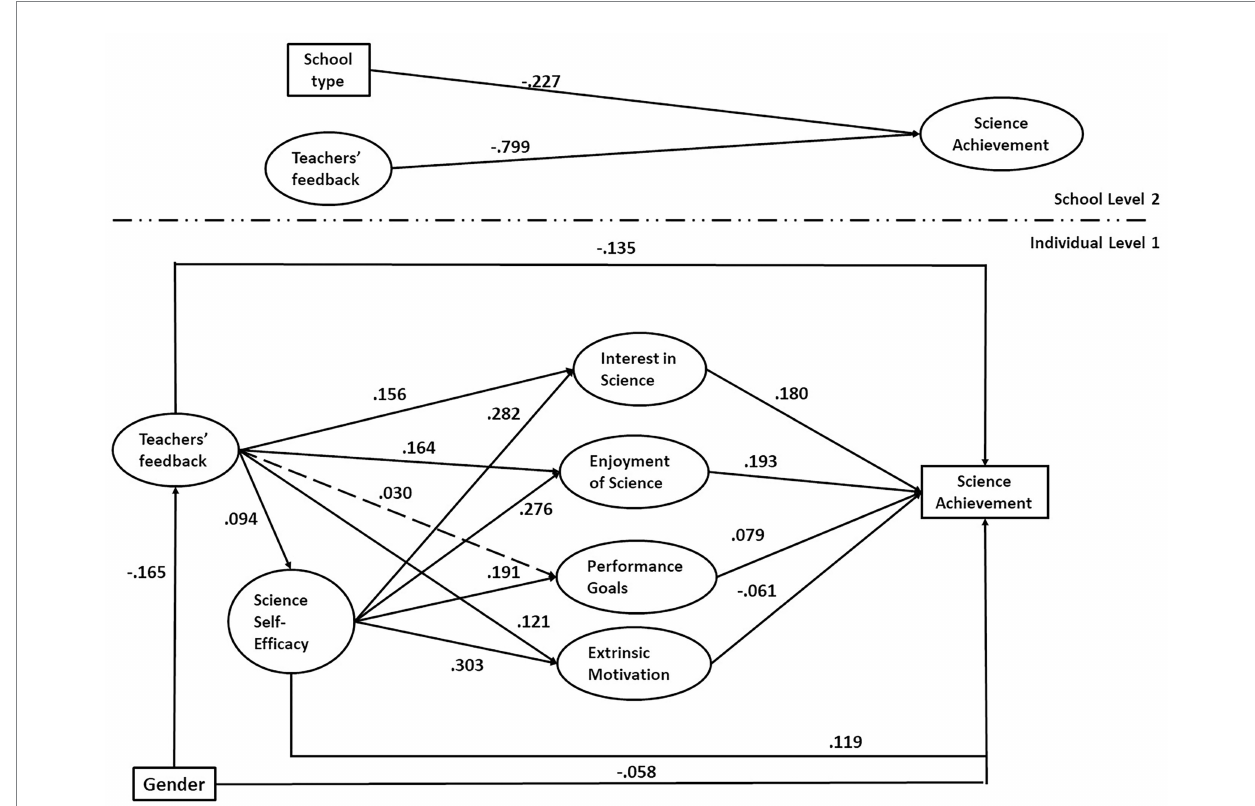
FIGURE 2 Path diagram of the serial multiple mediation multilevel SEM model (Model